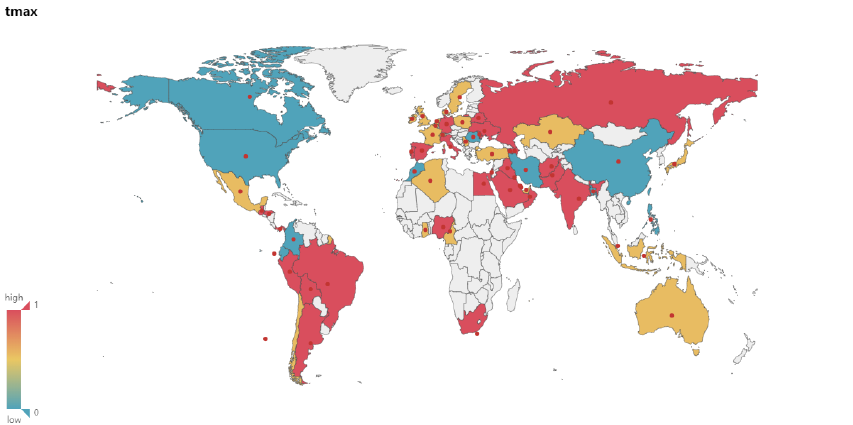
Figure 3. Correlation between New and